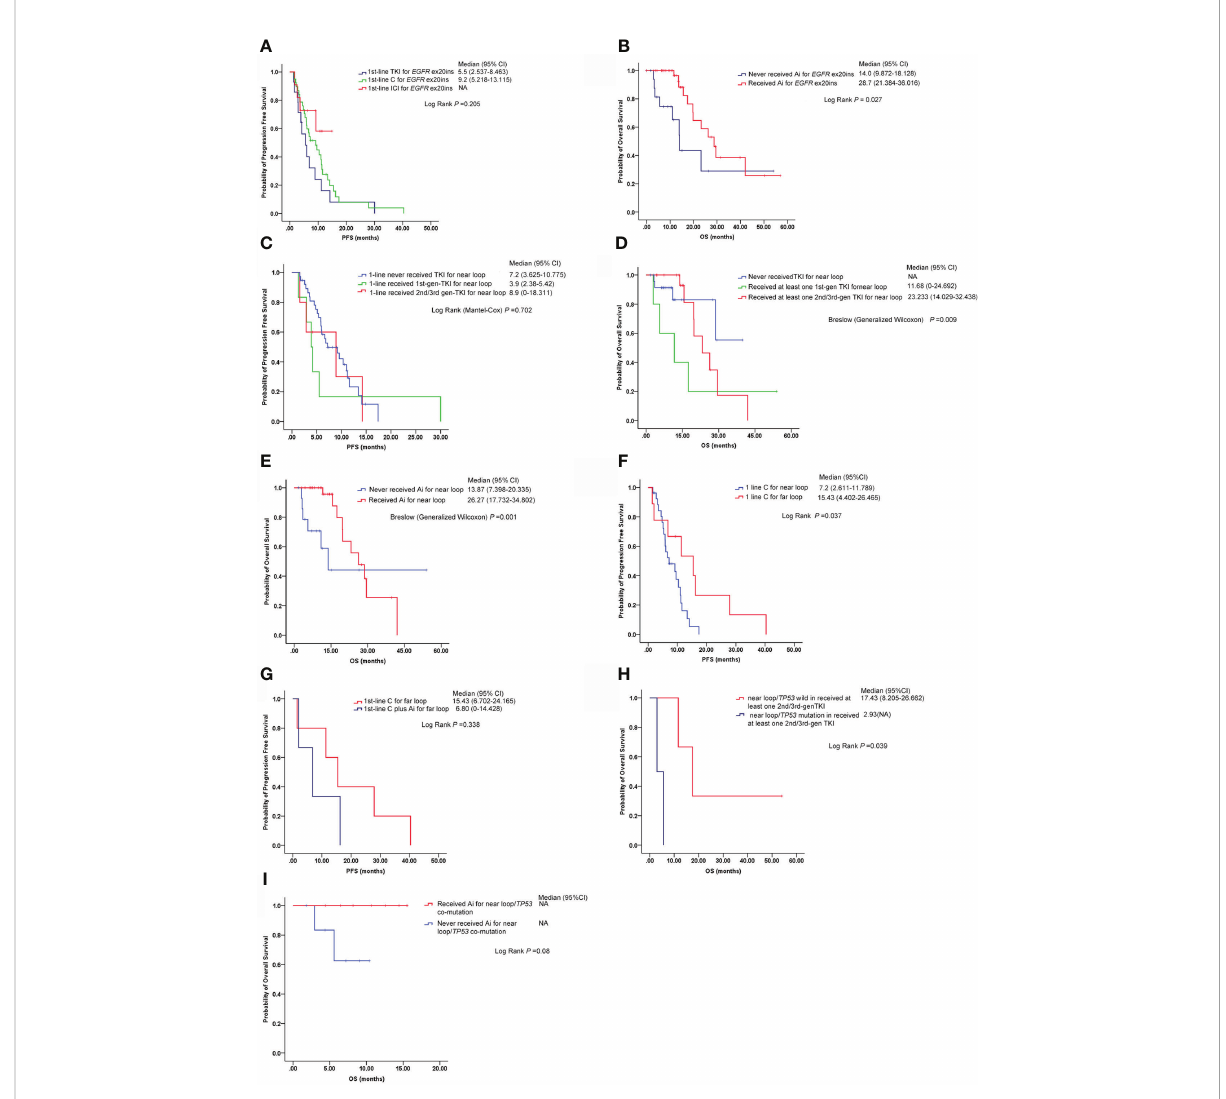
FIGURE 3 Responses to different therapies in different EGFR ex20ins variants (near loop and far loop). (A) Comparison of median PFS among fi rst-line chemotherapy (chemotherapy, C), fi rst-line EGFR - TKIs (all generations) (TKI) and fi rst-line immunotherapy (ICI) in EGFR ex20ins NSCLC patients. (B) Median overall survival (mOS) time of two groups: the patients who never received anti-angiogenesis (Ai) therapy and the patients who received anti-angiogenesis therapy. (C) Median progression-free survival (mPFS) time of EGFR ex20ins near-loop variants under different EGFR- TKI treatments as fi rst-line. (D) Median overall survival (mOS) time of EGFR ex20ins near-loop variants under different EGFR-TKI agents. (E) Comparison of the median overall survival (mOS) time between the group that never received anti-angiogenesis and the group that received anti-angiogenesis in EGFR ex20ins near-loop variants. (F) Median progression-free survival (mPFS) time of patients with EGFR ex20ins near-loop and far-loop variants on chemotherapy treatment as fi rst-line. (G) In EGFR ex20ins far-loop variants, the mPFS between mono-chemotherapy and chemotherapy plus anti-angiogenesis was compared. (H) In the group with at least one second-/third-generation EGFR-TKI, the mPFS between EGFR ex20ins near-loop/ TP53 -wild and EGFR ex20ins near loop/ TP53 -mutation is shown. (I) Comparison of mOS between those who never received anti-angiogenesis treatments and those who received anti-angiogenesis agents in patients with EGFR ex20ins near loop/ TP53 - mutation. C, Chemotherapy; TKI, EGFR-TKIs; Ai, anti-angiogenesis; ICI, immunotherapy; NA, not